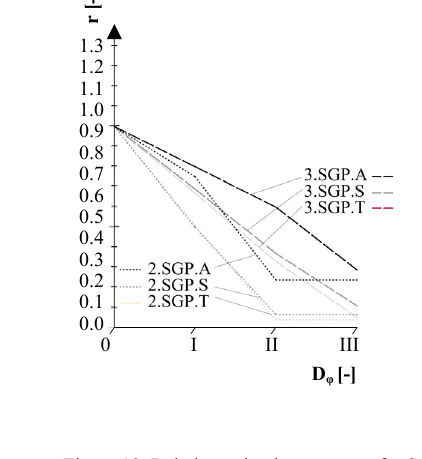
Figure 17: Relative redundancy curves for PVB laminated glass beams.